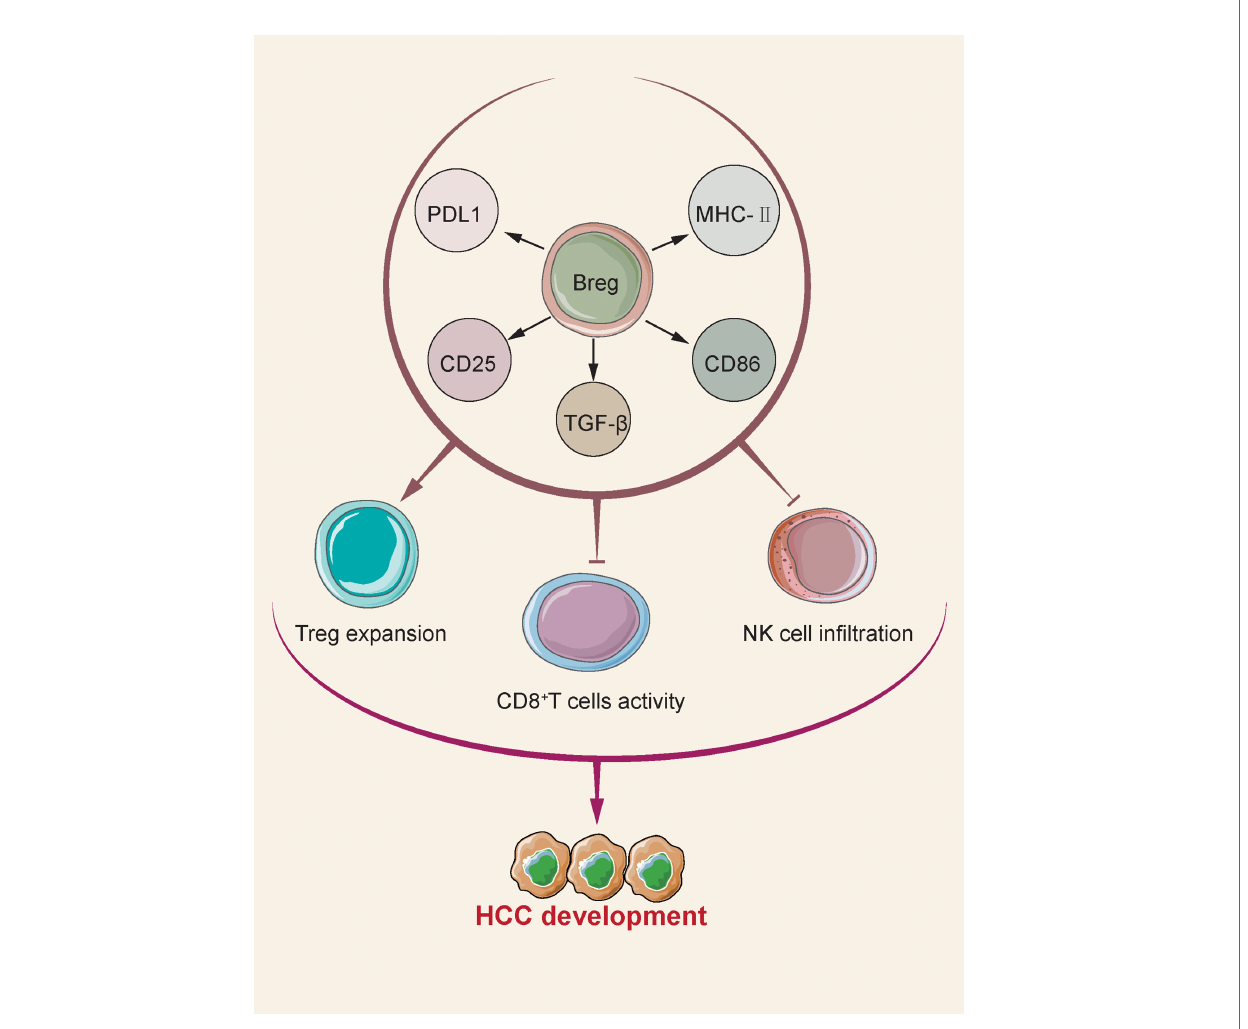
FIGURE 3 | Bregs regulates other immune cells, affecting tumor development. After B cells migrate to the tumor bed, they develop a Breg phenotype and increase the expression of membrane-bound TGF- b , CD25, MHC-II, and costimulatory ligands CD86 and PD-L1. Breg supports Treg expansion, inhibits IFN- g production and CD8 + cytolytic T cell activity, thereby inhibiting anti-tumor response and leading to enhanced tumor